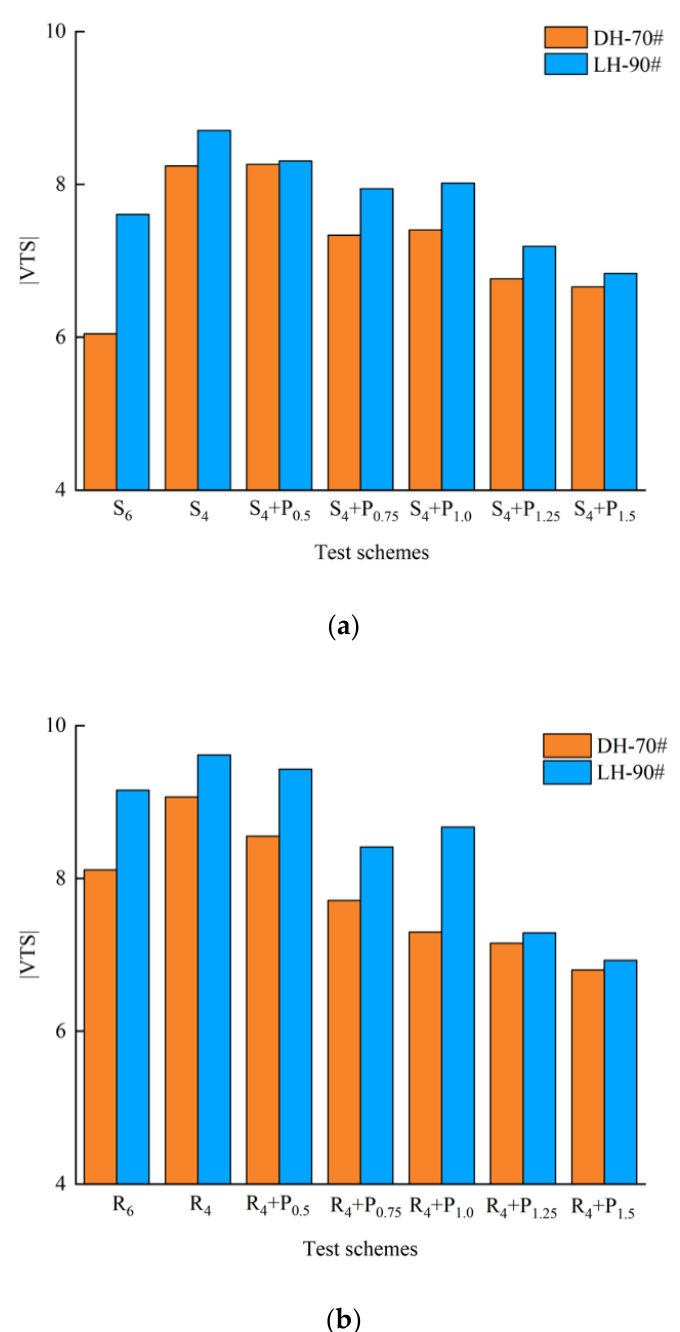
Figure 21. SBS/SBR-PPA variation curve of |VTS|: ( a )|VTS| of PPA–SBS with DH–70# and LH–90#; Figure 21 . SBS/SBR-PPA variation curve of |VTS|: ( a )|VTS| of PPA – SBS with DH – 70# and LH – ( b )|VTS| of PPA–SBR with DH–70# and 90#; ( b )|VTS| of PPA – SBR with DH – 70# and LH – 90#.